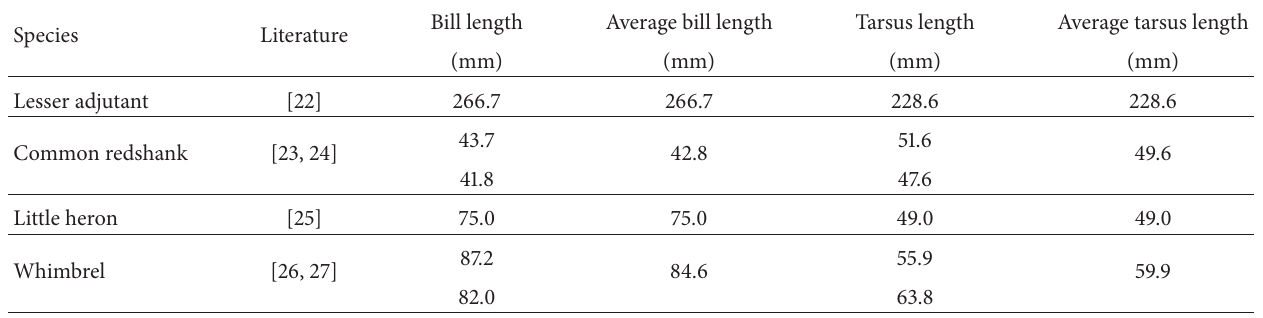
Table 1: Measurements of bill size and tarsus length based on previous studies.